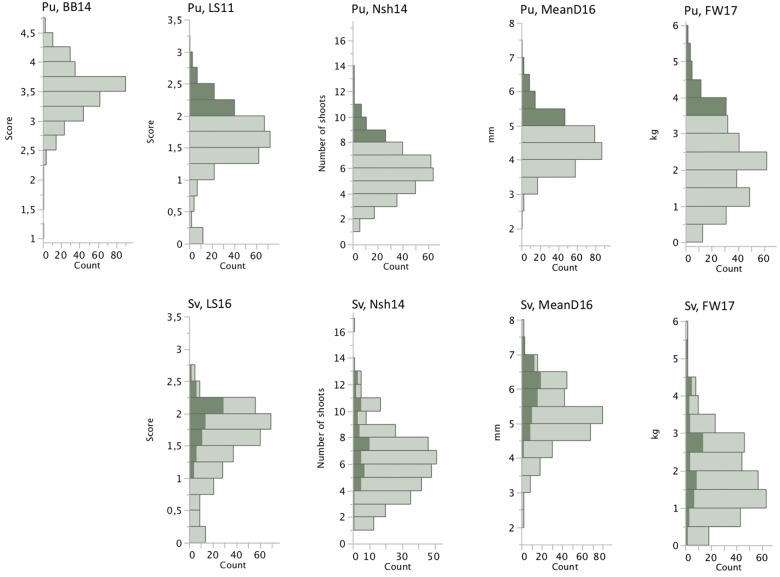
Phenotypic distributions of a subset of the measured traits based on arithmetic means of each accession in the two field experiments, Pustnäs and Svalöv. Shaded bars indicate the accessions with highest trait mean values in Pustnäs and the values for the corresponding trait and the same accessions in Svalöv.